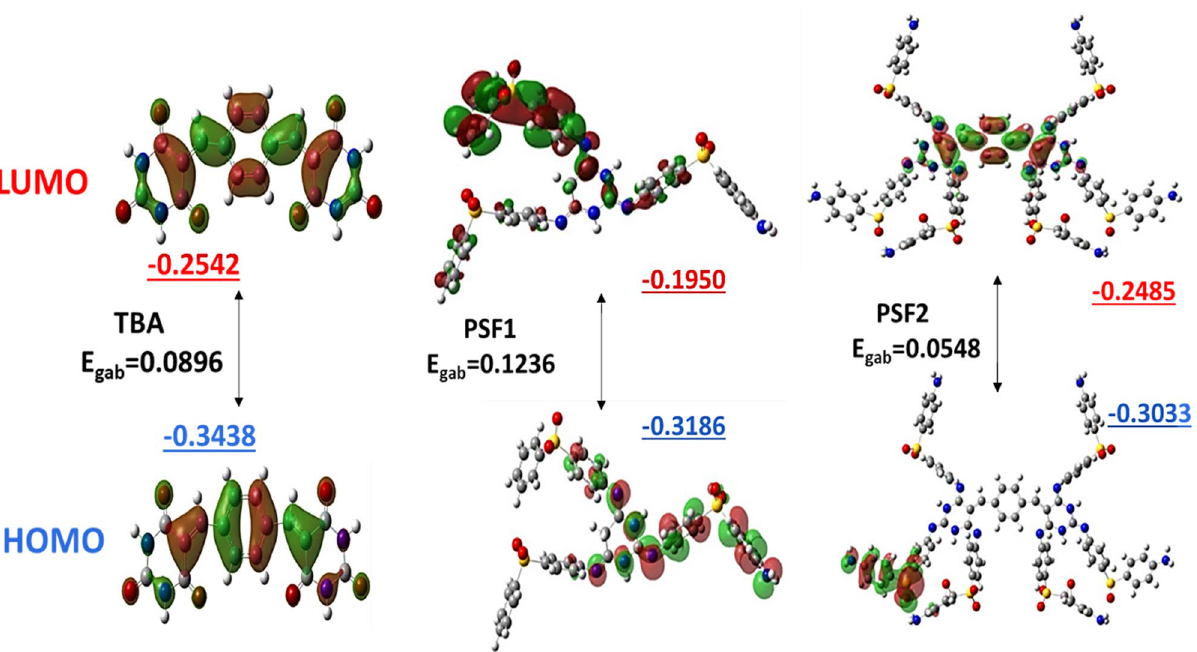
Figure 3. The shapes of HOMO, LUMO of TBA, PSF1, and PSF2 were calculated by using DFT, B3LYP/6-31G